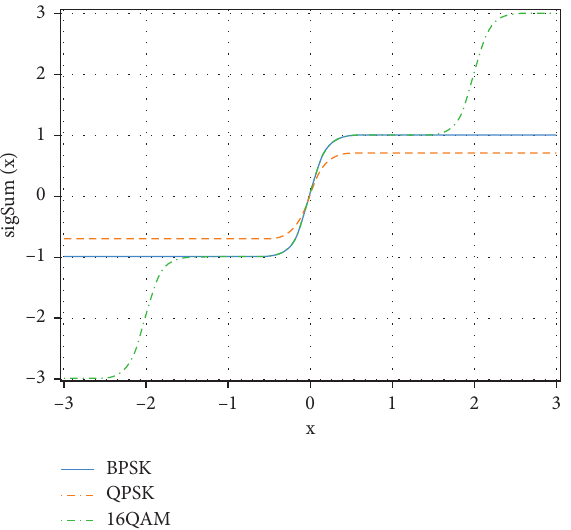
Figure 3: sigSum function mapping curve under different mod- ulation modes.